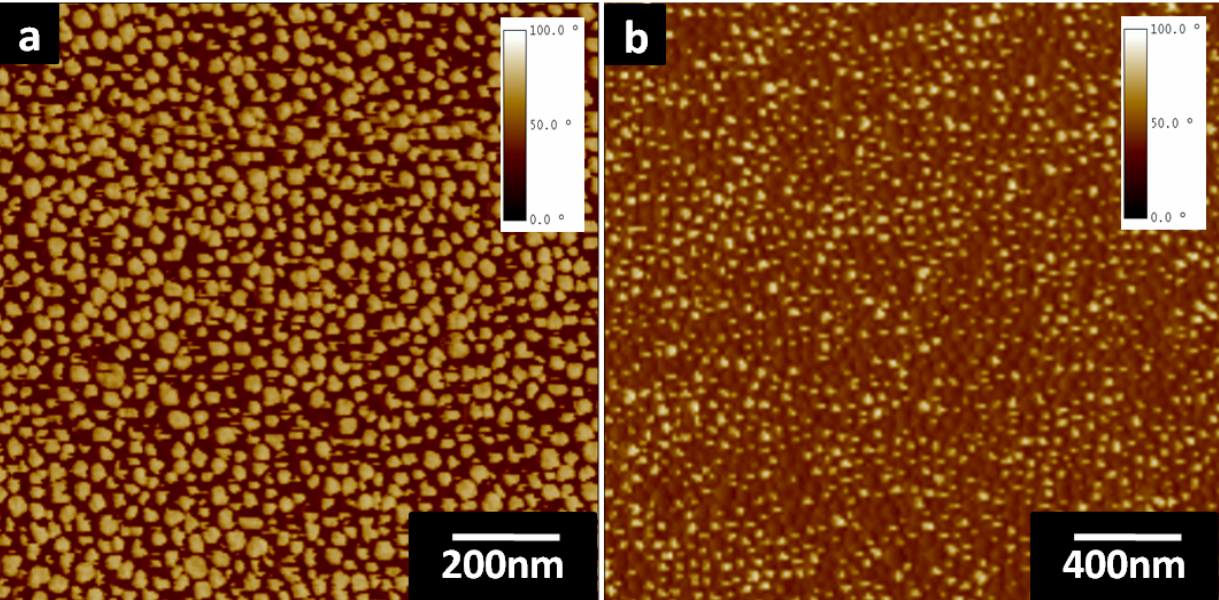
Figure 3. Phase contrast AFM images of the surfaces of (a) PS- b -PEO/SiO containing 20 vol% inorganic precursors prepared from spin coating toluene solutions; (b) identical film in (a) after removing the BCP templates. The Ti/Si mass ratio is